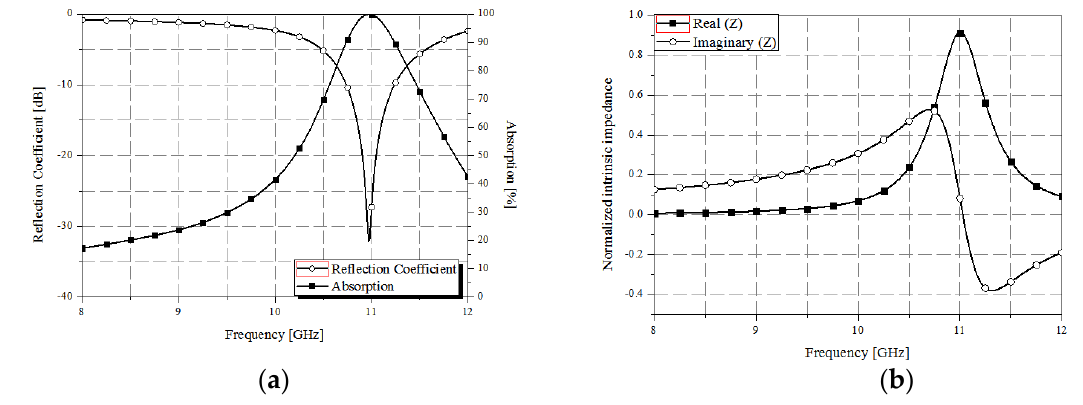
Figure 2. ( a ) Simulated reflection coefficient and absorption of the proposed absorber; ( b ) Normalized complex impedance of the proposed absorber.